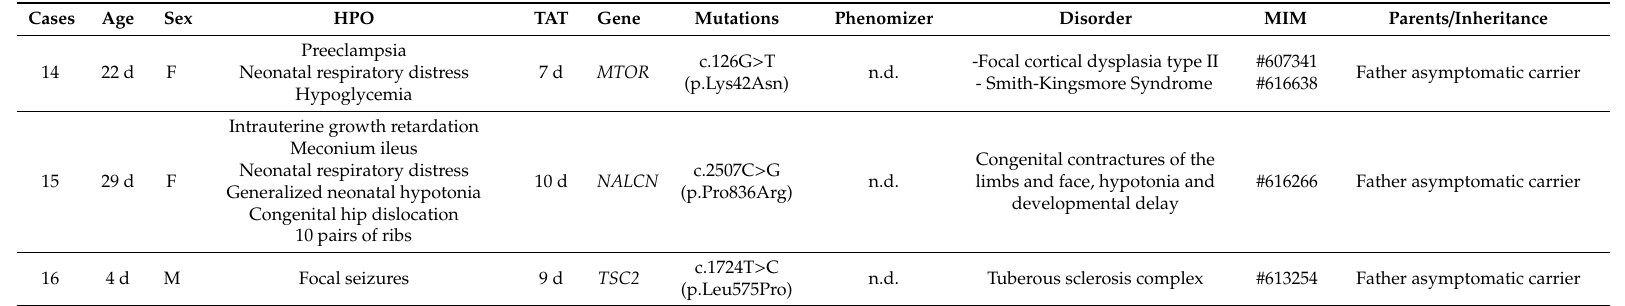
Table 2. Demographic and clinical data and genetic findings in patients with non-definitive / non probable causative